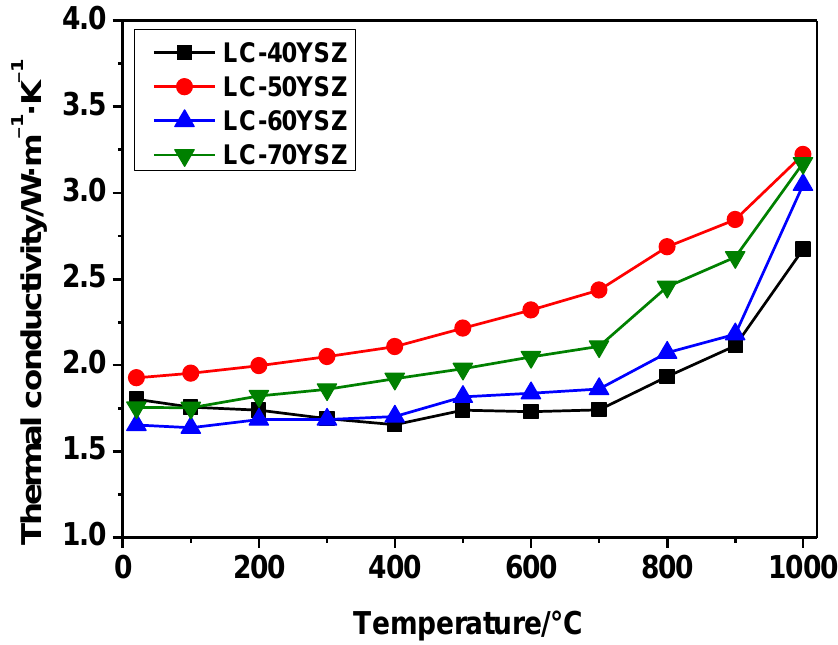
Figure 10. Temperature dependence of the thermal conductivity of the LC-YSZ composites.